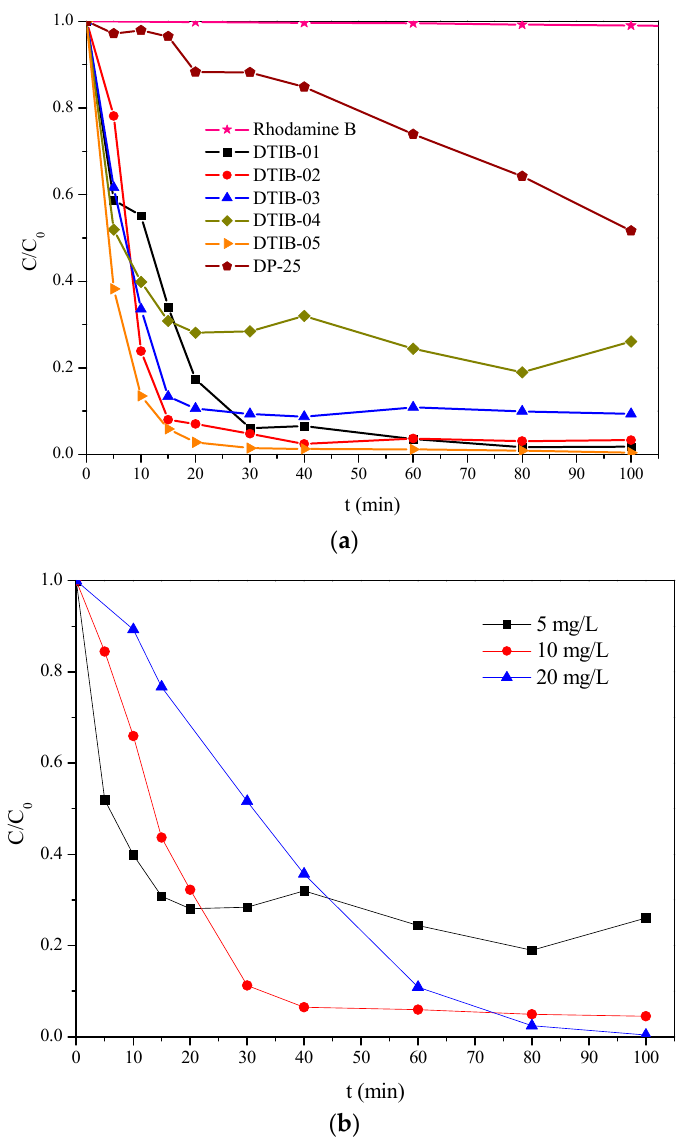
Figure 11. ( a ) Adsorption (in the dark) and degradation (during exposure to visible light) rates of Rhodamine B for all the obtained photocatalysts; ( b ) Adsorption and degradation rates for increasing concentrations of Rhodamine B using the same DTiB-04 photocatalyst.